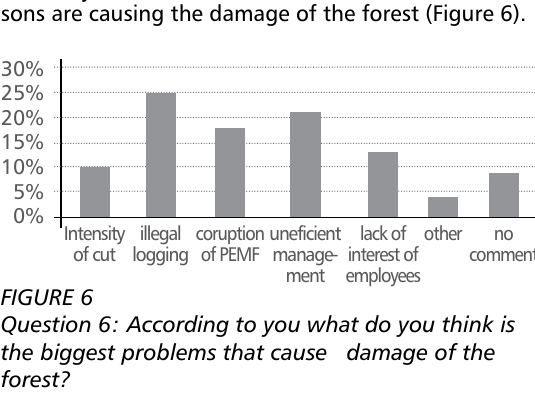
Question 6: According to you what do you think is